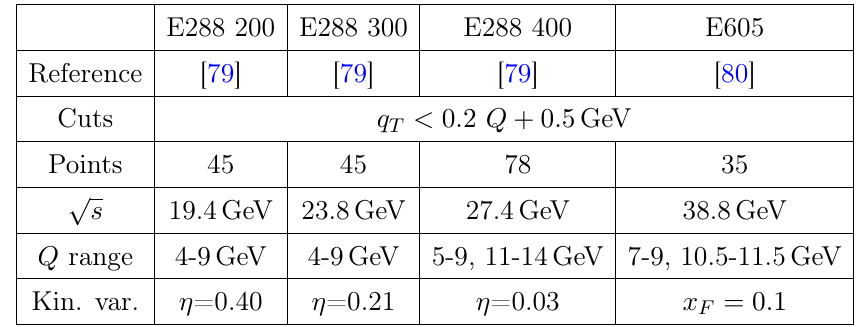
Table 3 . Low energy Drell-Yan data collected by the E288 and E605 experiments at Tevatron, with different center-of-mass